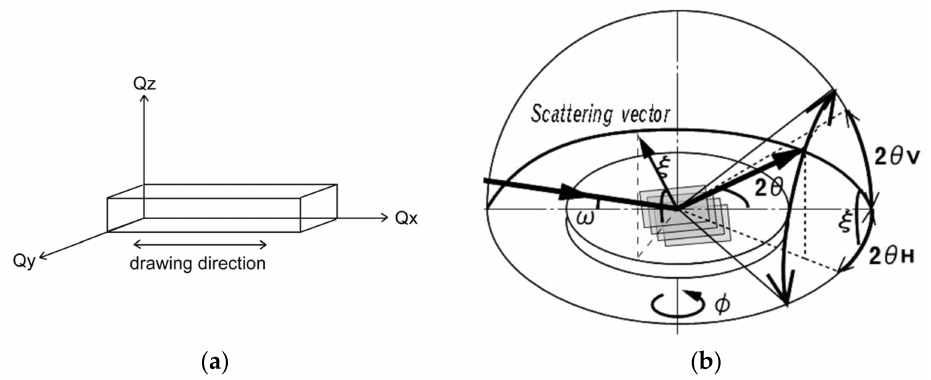
Figure 1. ( a ) The geometry of the scattering vectors with the drawing direction of friction transfer; ( b ) The schematic diagram of ED-GIXD geometry. The scattering angle 2 θ is composed of horizontal angle 2 θ H and vertical angle 2 θ V